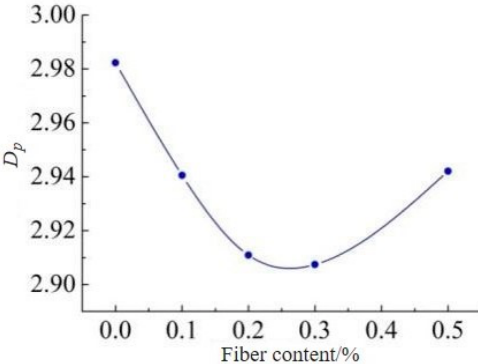
Figure 17. ln( W n / r n 2 )-ln Q n linear fitting curve.